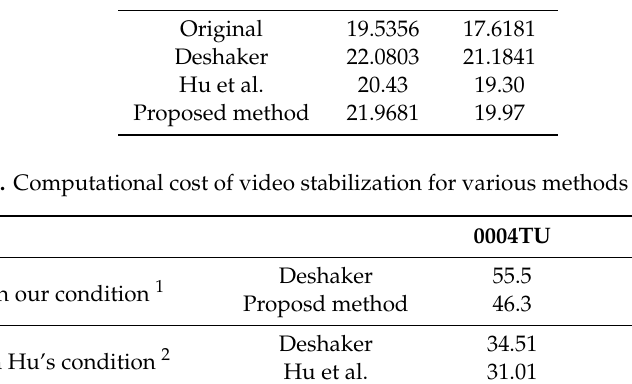
Table 3. Computational cost of video stabilization for various methods (ms/frame).